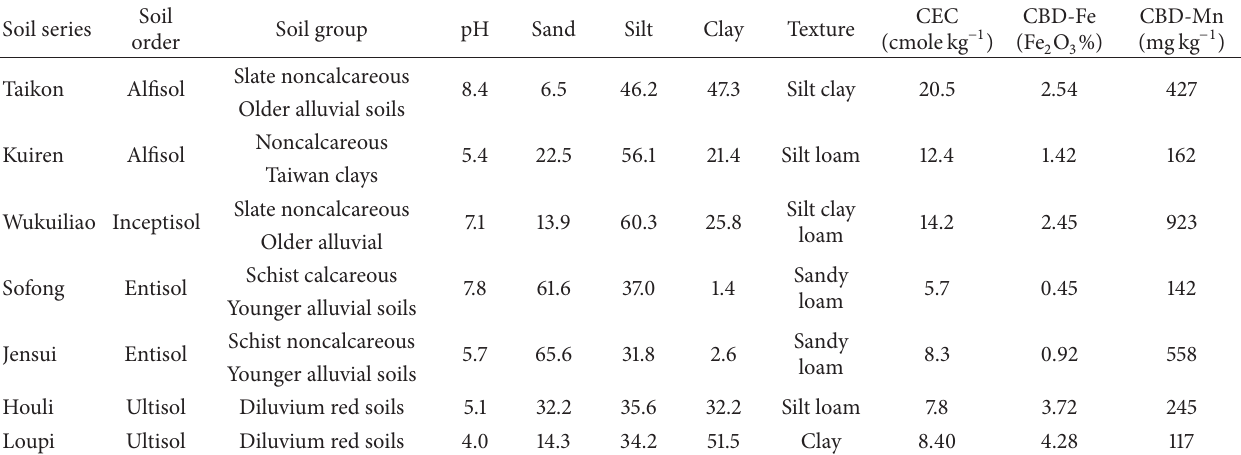
Table 1: Basic physical and chemical properties of the representative soil samples.